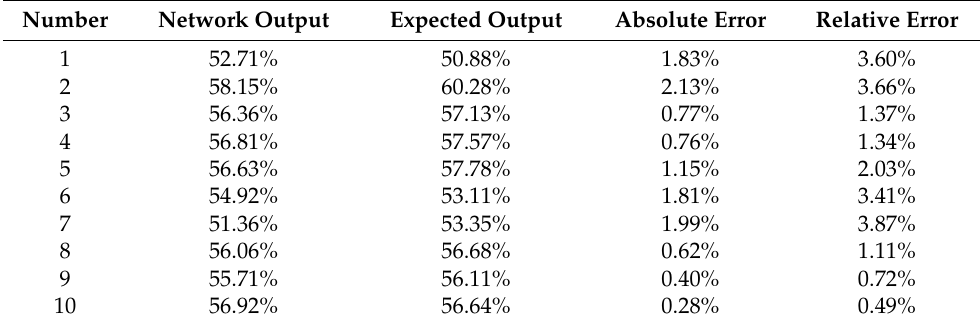
Table 2. The simulated predicted data and expected output values of BP neural network prediction model for matte